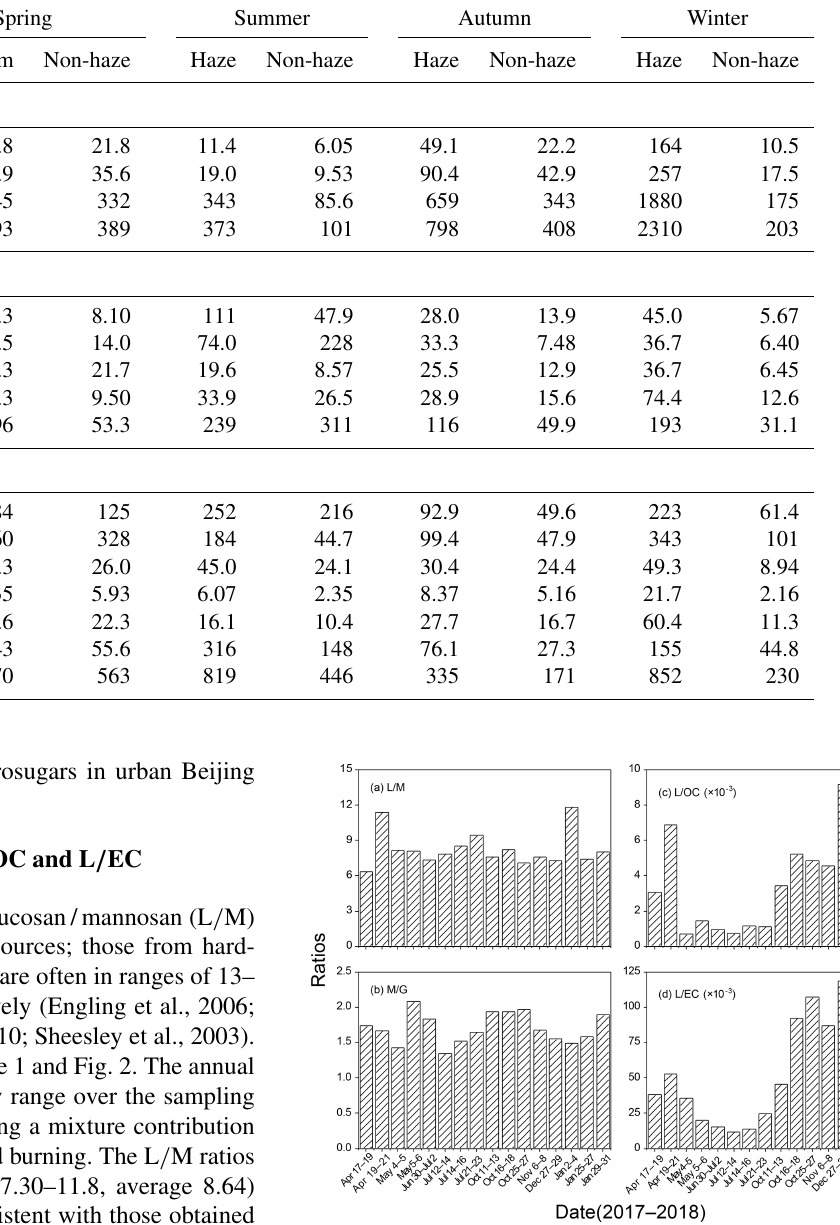
Table 2. Abundances and seasonal variations in anhydrosugars and other saccharides in haze and non-haze days from April 2017 to Jan- uary 2018. Compounds